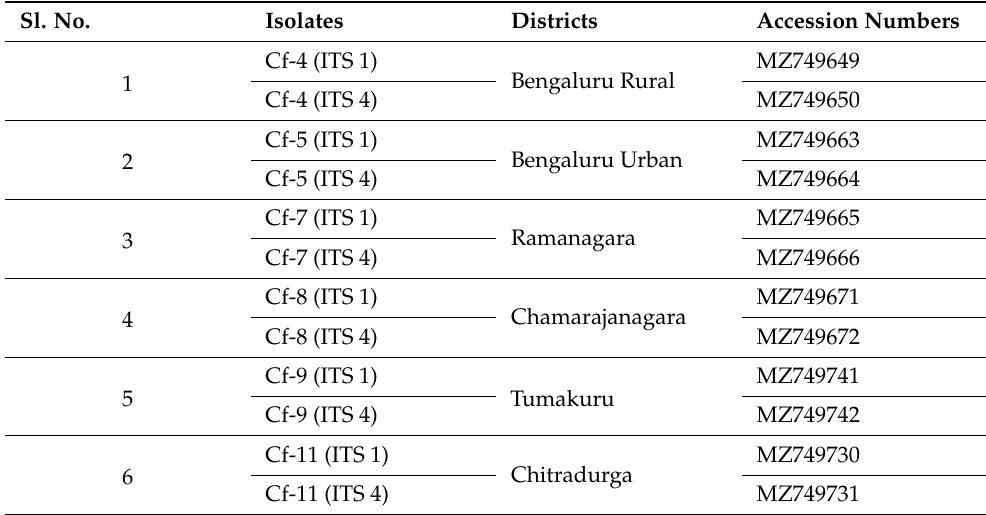
Table 4. Accession numbers of Ceratocystis fimbriata nucleotide sequences submitted to NCBI, GenBank. Sl.